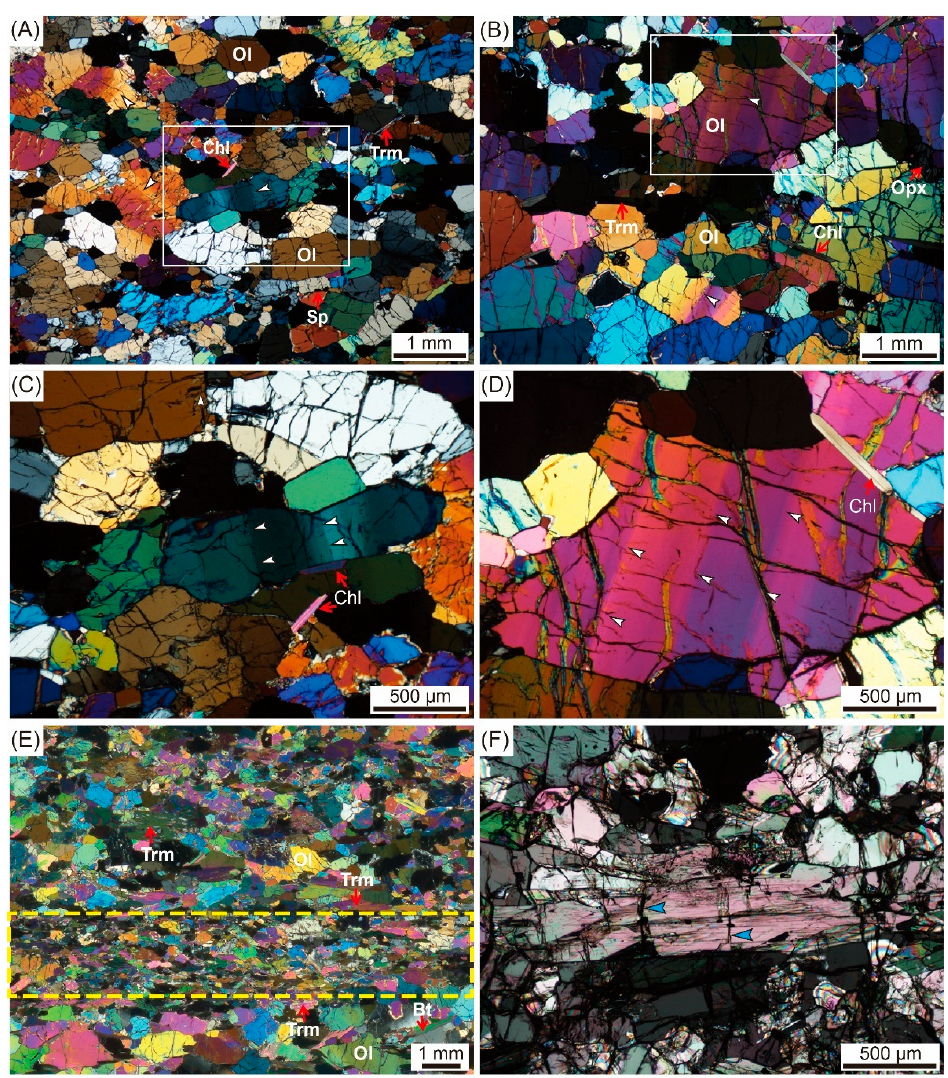
Figure 2. Optical photomicrographs of samples in transmitted, cross-polarized light. ( A , B ) Representative wide-view images of samples 447 ( A ) and 448 ( B ). Olivine grains are well elongated along the foliation. White arrow heads mark the clear subgrain boundaries in olivine. White boxes mark the location of the areas shown in Figure 2C,D. ( C , D ) Enlarged image of the olivine crystals showing clear subgrain boundaries for sample 447 ( C ) and sample 448 ( D ). White arrow heads indicate subgrain boundaries in olivine. ( E ) Representative wide-view images of samples 443. Tremolite-rich layer is marked by yellow dashed lines. ( F ) Magnified view of tremolite in sample 443. Blue arrows mark the fractures in the tremolite. Abbreviations: Ol: olivine Trm: tremolite, OPx: orthopyroxene, Chl: chlorite, Sp: spinel, BT: biotite.